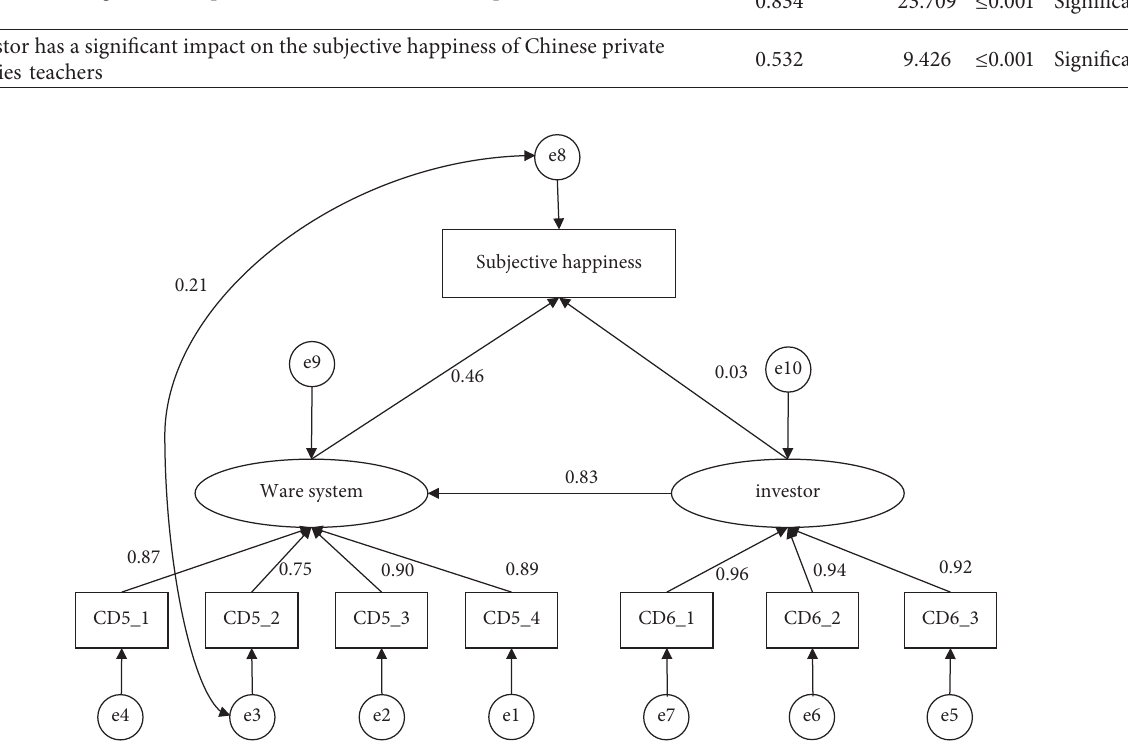
Figure 5: Structural equation model analysis. Table 6: Variance violate estimation test